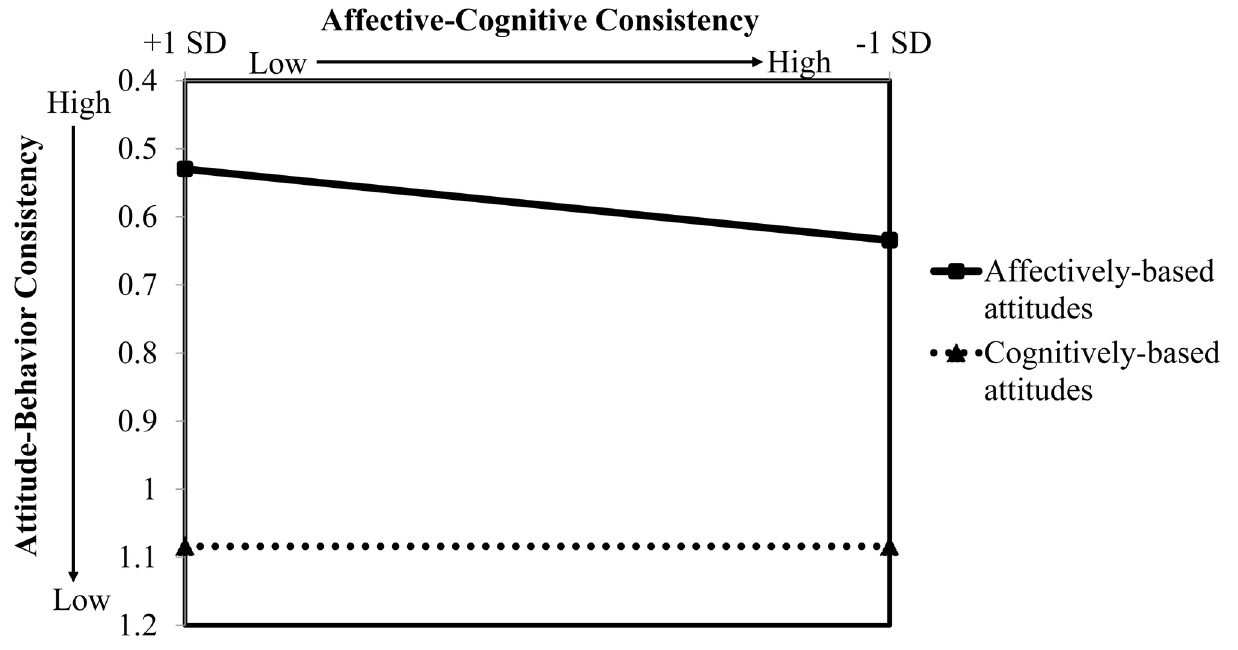
Figure 1. Effects of attitude base and affective-cognitive consistency on intergroup consummatory behaviors in Study 1. This figure was plotted by using the unstandardized regression weights with affective-cognitive consistency along the abscissa at + 1 SD from the mean. Lower affective-cognitive consistency scores signified higher affective-cognitive consistency of group attitudes. Similarly, lower attitude-behavior consistency scores indicated a stronger relation between attitudes and behaviors. Results show that affectively-based attitudes predicted intergroup consummatory behaviors more strongly than cognitively-based attitudes regardless of affective-cognitive